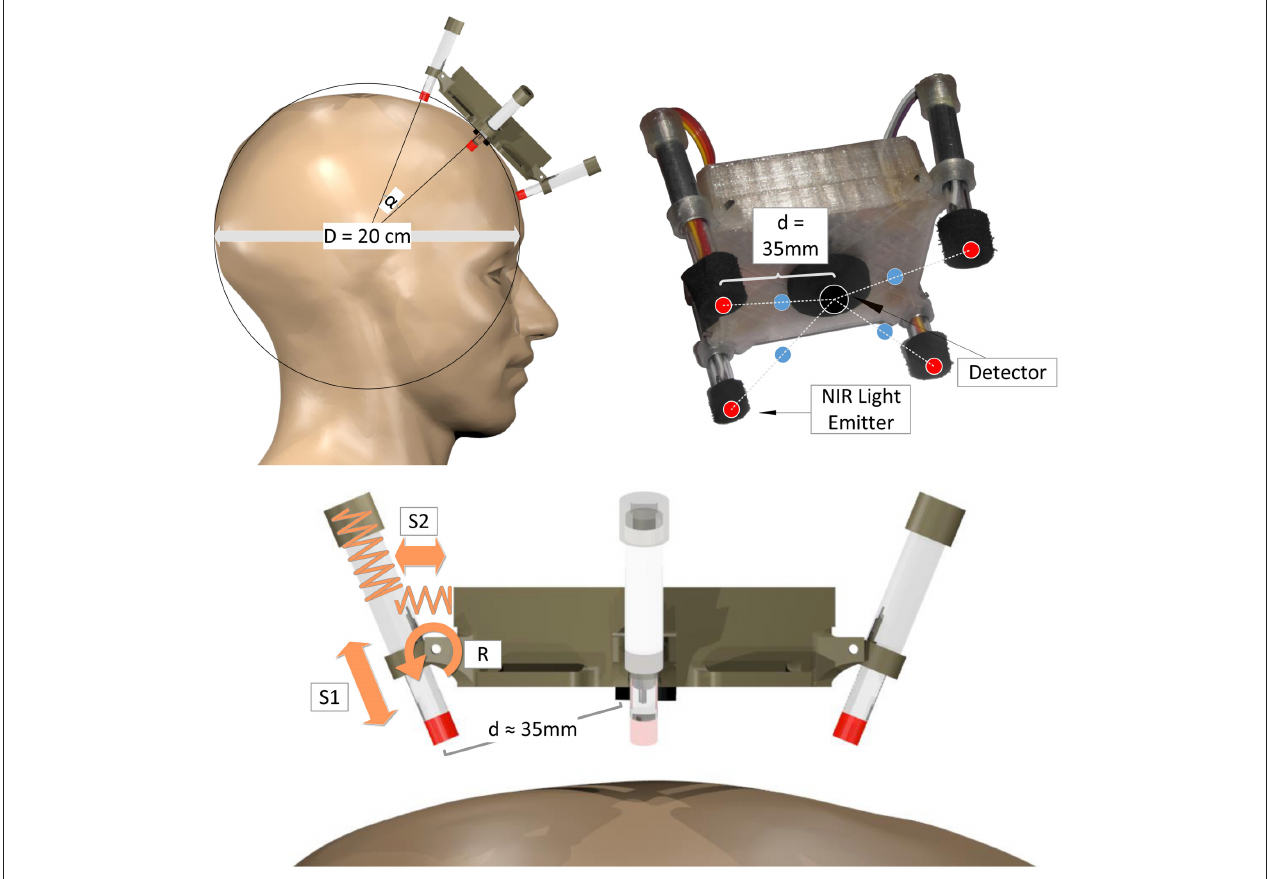
FIGURE 4 | Mechanical spring-loaded concept: Spherical head approximation (top left), geometric channel arrangement (red: NIR LEDs, black: photo detector, blue: measurement points of highest sensitivity; top right), spring-loaded mechanical design illustrated on one LED-holder (bottom). Spring S1 for alignment and buffering, spring S2 and rotatory joint R for perpendicular